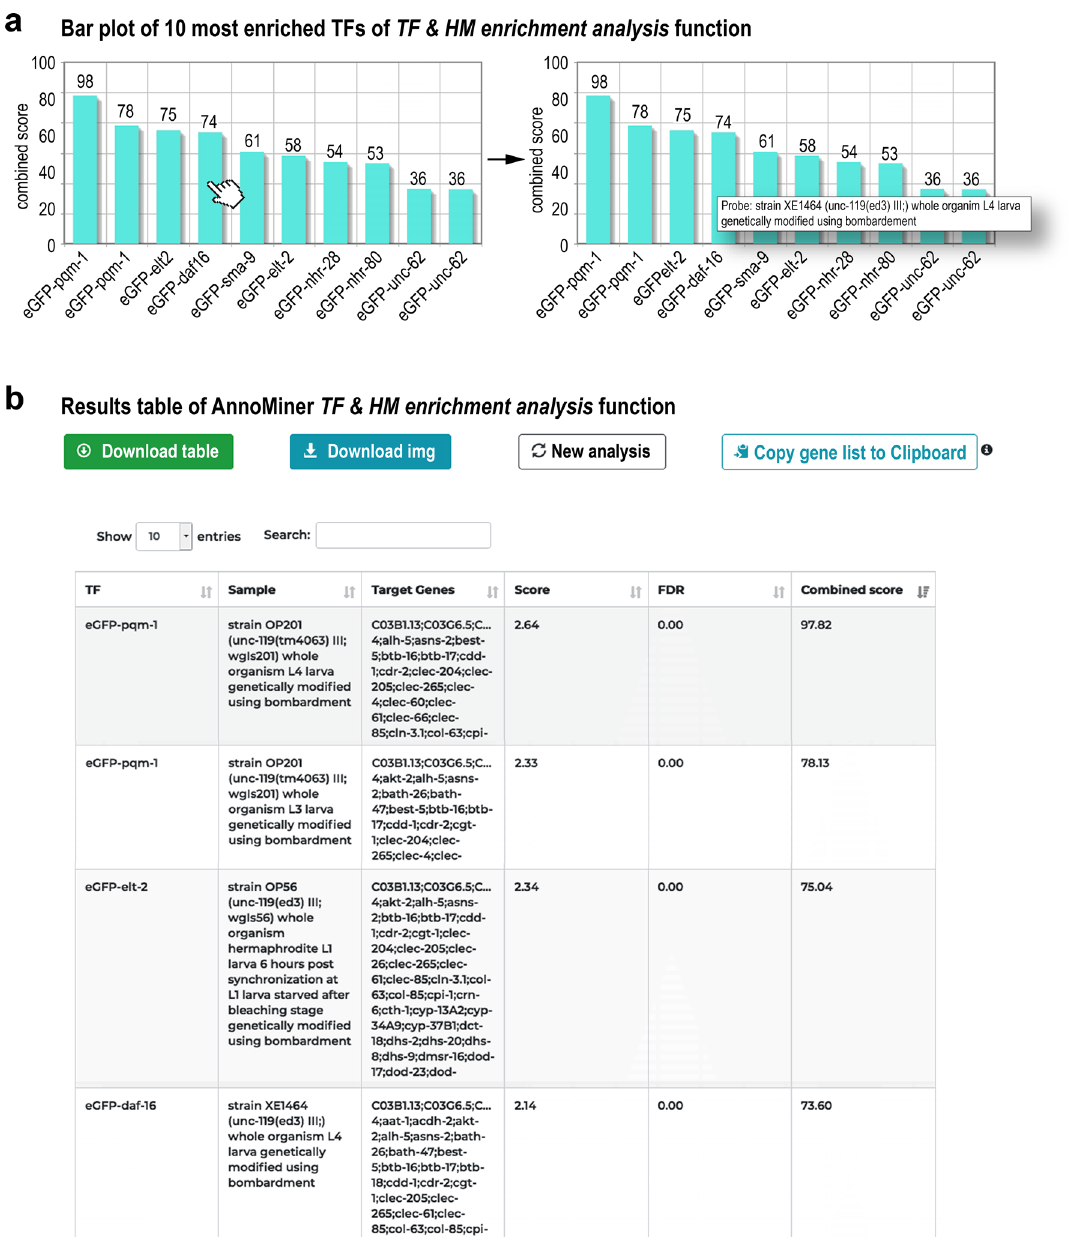
Figure 6. TF & HM enrichment analysis function of AnnoMiner. The output of a TF & HM enrichment analysis in AnnoMiner is first a plot of the top 10 enriched transcription factors ( a ). The identity of the enriched TF with its combined score is shown. Hovering over the bar of a TF will reveal meta-information associated with the ChIP-seq dataset ( b ). Second and at the same time, a table is returned, which contains the information on all TFs stored in the AnnoMiner database and their enrichments in the submitted gene list. The table is sortable and downloadable. Once downloaded, it includes information on the sample, the target gene for each TF, as well as the score, FDR and combined score. Target gene lists can be copied to the clipboard for further analysis. For demonstrating the TF enrichment analysis function of AnnoMiner, we took advantage of a study identifying direct daf-16/FoxO targets from a longevity study ( 53 and GEO dataset GSE72426). In this study, the authors looked for isoform-specific targets of daf-16. We combined the list of all DAF-16 isoform targets and submitted it to AnnoMiner for identifying enriched transcription factors. AnnoMiner displays the 10 most enriched TFs, with their combined score indicated in the plot ( a ) as well as the table of all TFs stored for C. elegans and including enrichment information for the submitted gene list. Daf-16 is the fourth hit; pqm-1, as well as elt-2, which both precede daf-16 in the hitlist, have been shown to bind to daf-16 response